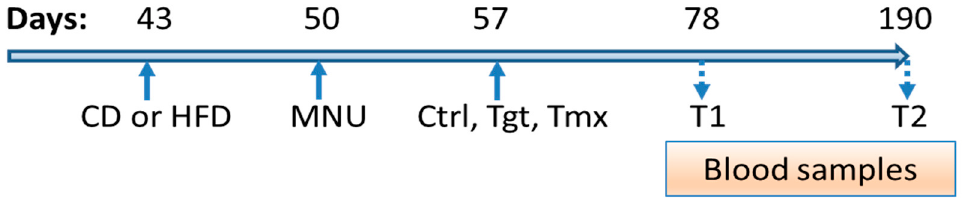
Figure 1. Diet and Treatment process. Diets: standard diet (CD); high fat diet (HFD); Times: T1, 78 days of age; T2, 190 days of age; Treatments: Ctrl, control; Tgt, targretin; Tmx, tamoxifen.